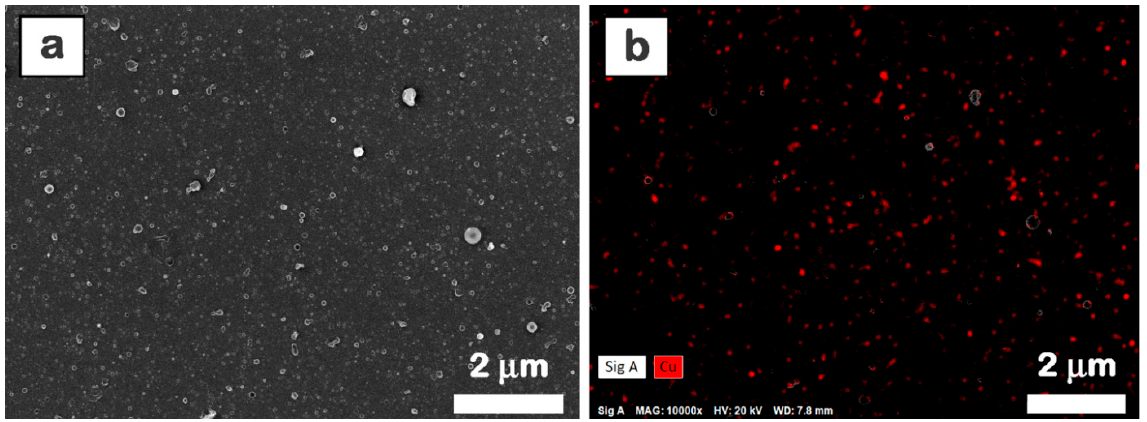
Figure 5. FESEM image ( a ) and EDX mapping ( b ) only for Cu element of P4 film deposited by MAPLE on silicon.